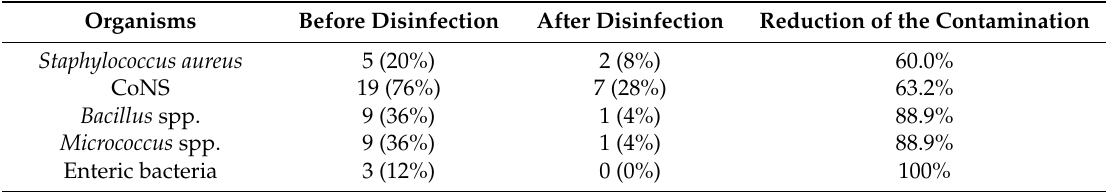
Table 1. Percentage evaluation of bacteria isolated from mobile phone surfaces ( n = 25) before and after disinfection and reduction of